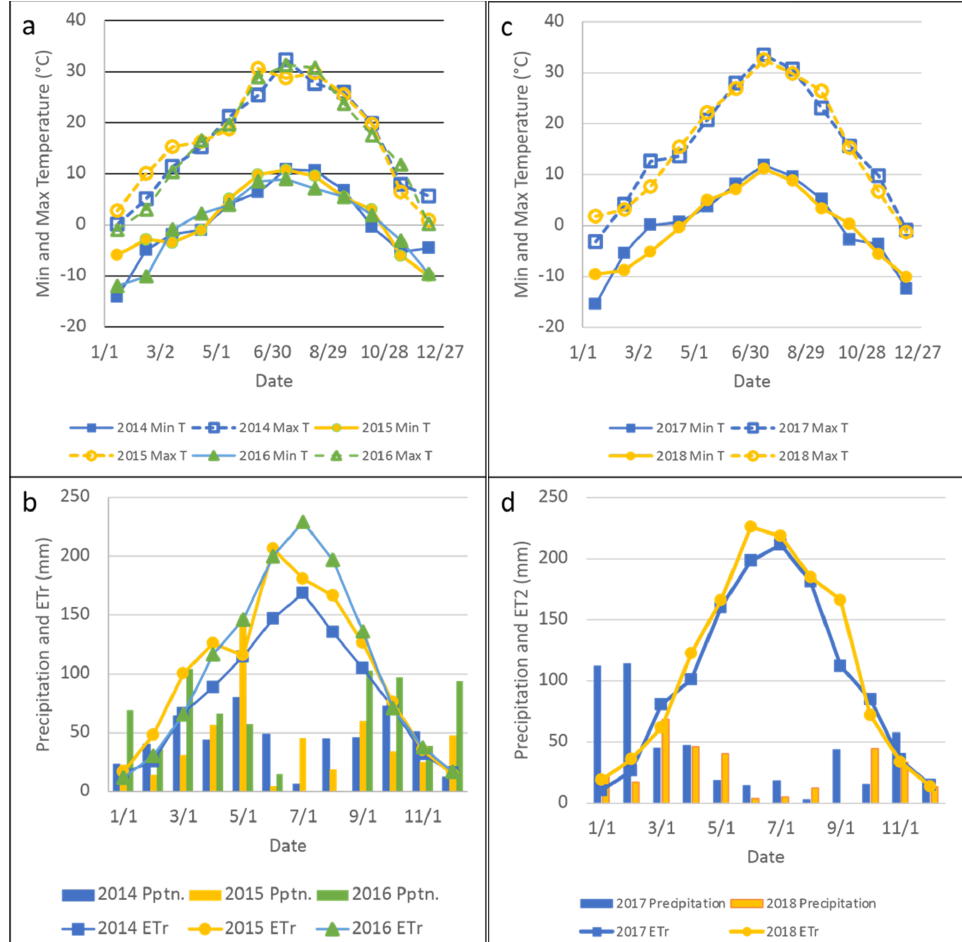
Figure 2. ( a ) Temperature and ( b ) precipitation (columns) and evapotranspiration demand (lines) for 2014–2016 and ( c ) temperature and ( d ) precipitation and evapotranspiration demand for 2017 and 2018.